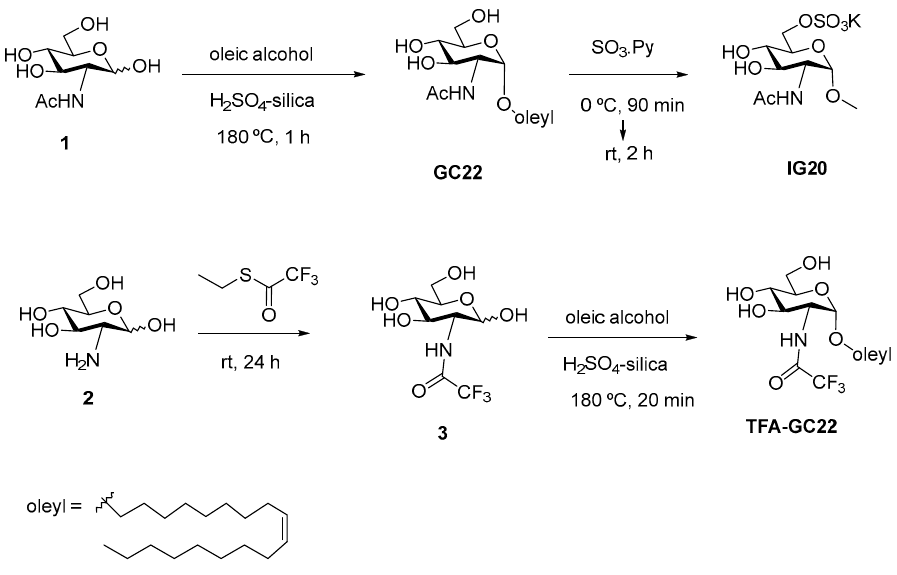
Figure 2. Synthesis of the glycosides GC22, IG20, TFA-GC22.